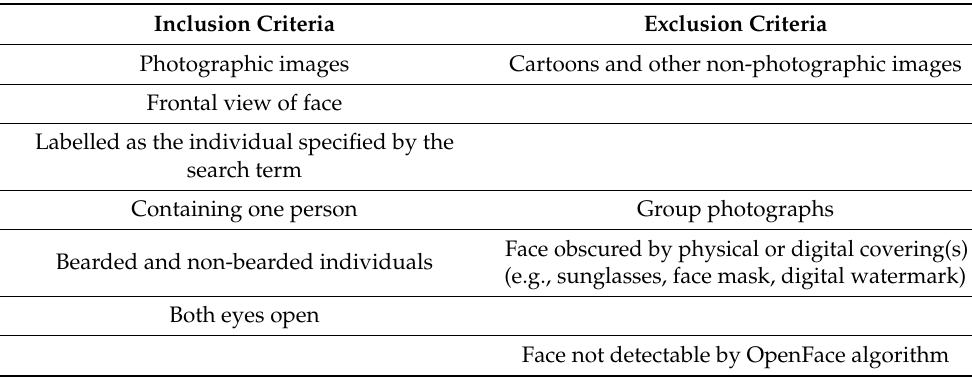
Table 3. Facial image inclusion and exclusion criteria for study